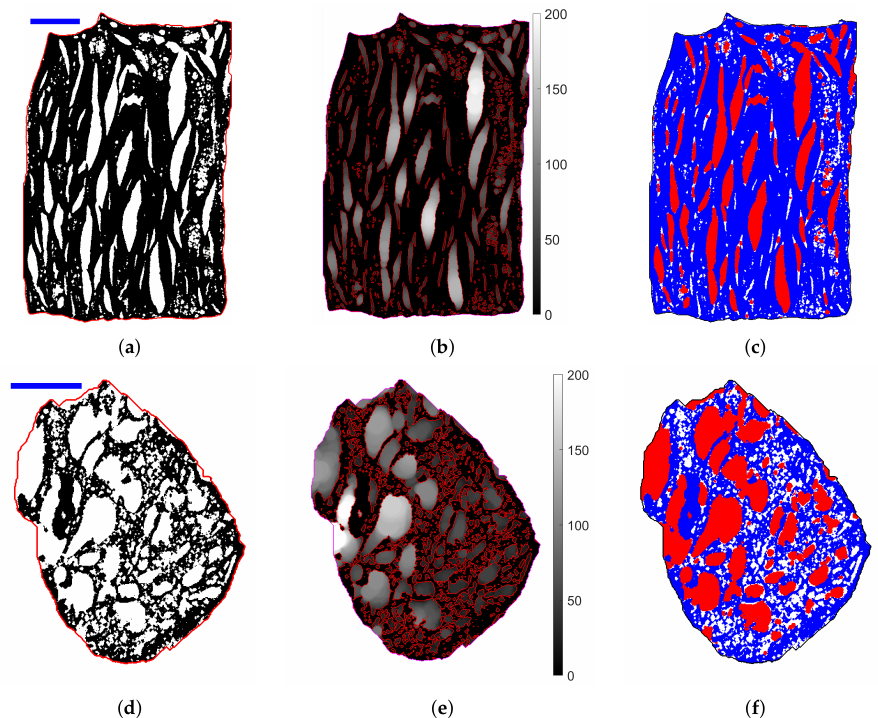
Figure 3. Cross-sections perpendicular to the x -axis in [S1] (top row) and [S2] (bottom row). The z -axis is horizontal. Thresholded tomography ( a , d ); the red line represents the outer sample envelope; the blue streaks correspond to 1 mm. Covering radius R c ( µ m) in the pores ( b , e ): the red lines indicate the contour of the solid phase. Mesopores (white), macropores (red) and apparent solid phase (blue) with a threshold R c , s = 30 µ m ( c , f